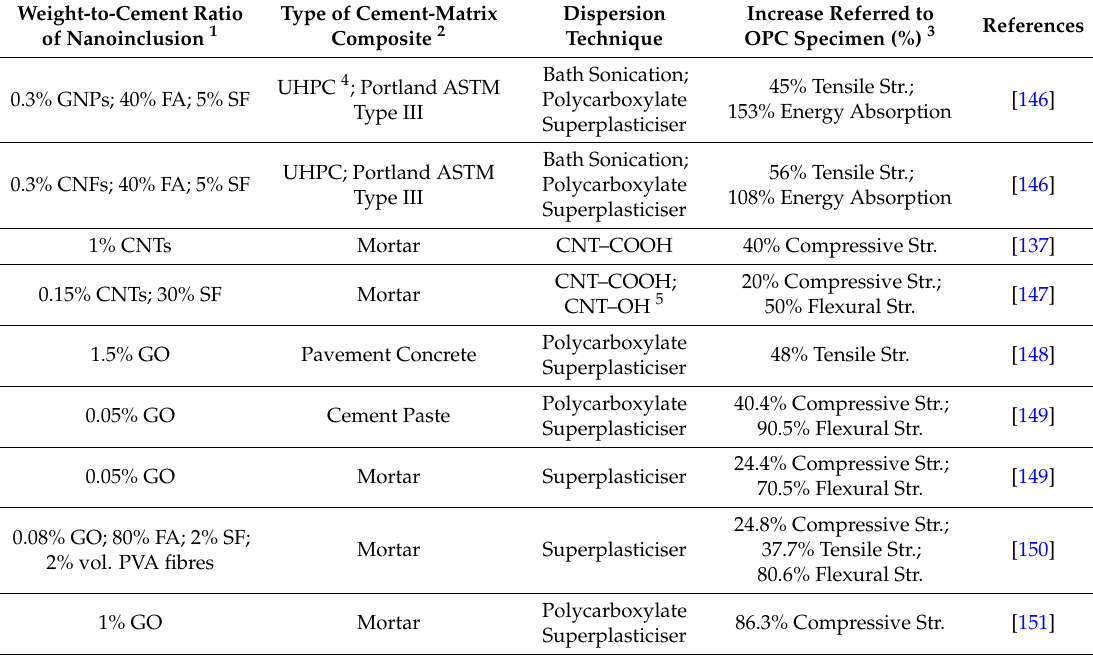
Table 3. Recent results on the improvement in the mechanical properties of cement matrices to date. Weight-to-Cement Ratio of Nanoinclusion